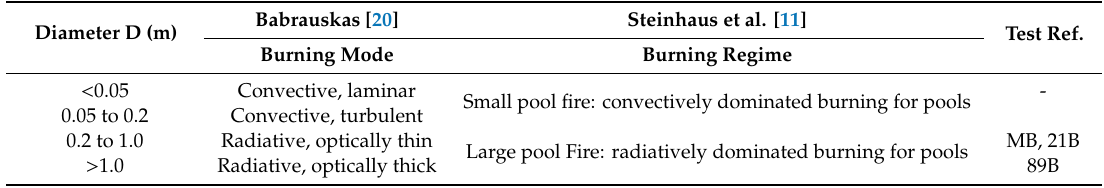
Test Ref. - MB, 21B